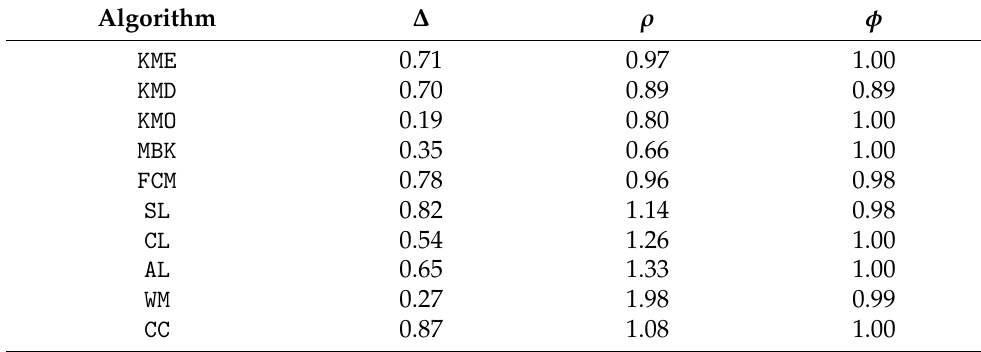
Table 5. Footprint analysis of the algorithms, where ∆ is the area, ρ is the density and φ is the purity.